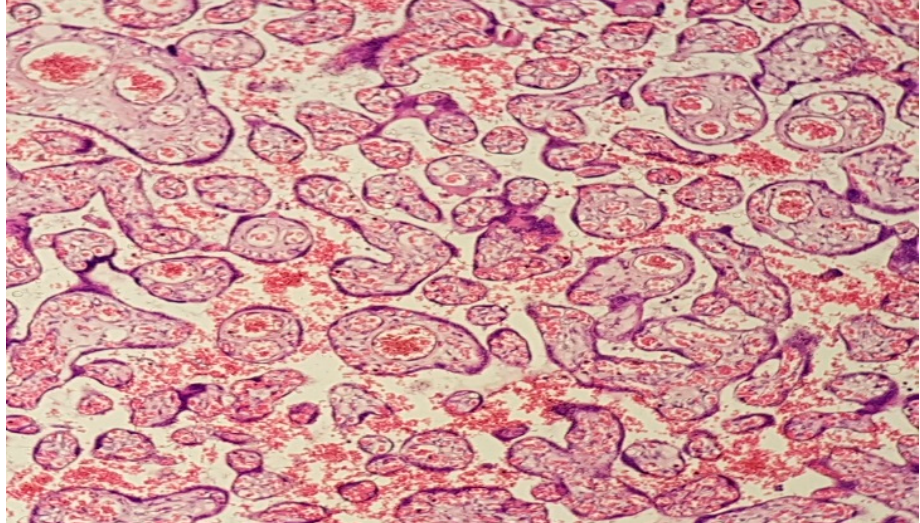
Figure 5. (Haematoxylin–eosin 10×). Chorangiosis shows excess numbers of villous capillaries lacking a surrounding, continuous layer of pericytes in the terminal villi.